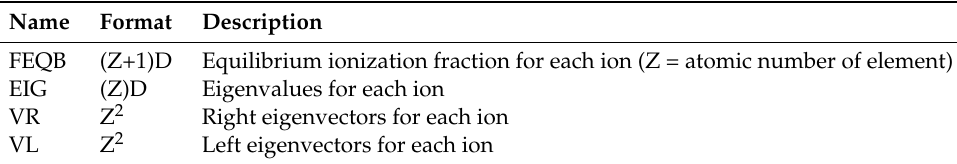
Table A10. APED eigenvector file definition. These can be in separate file for each ion or a separate Header Data Unit (HDU) in the same file for each. Data is stored at 1251 temperatures from 10 4 to 10 9 K, logarithmically spaced. Eigenvector and eigenvalue data is stored for solving non-equilibrium ionization balances, using the method of [53].